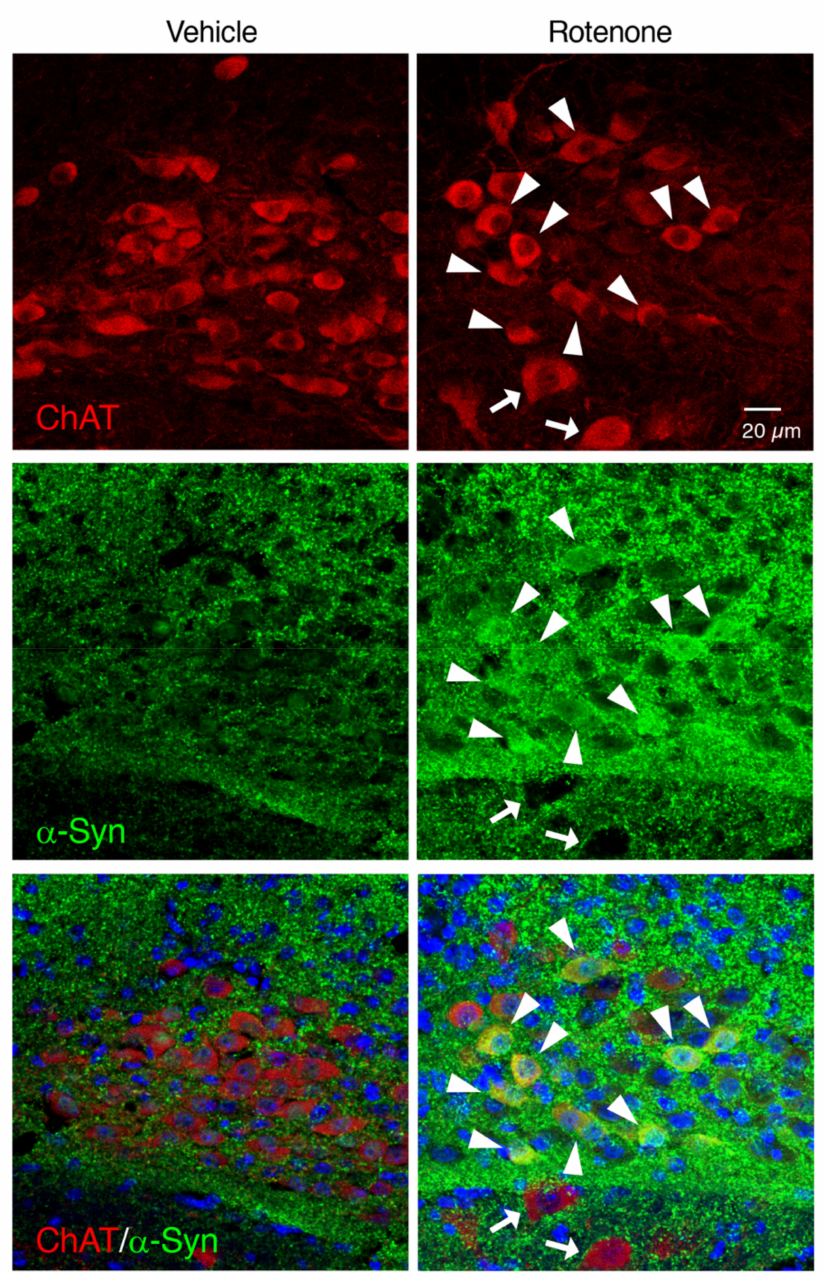
Figure7. Chronicexposuretolow-doserotenoneinduced α -Synaccumulationinthecholinergicneurons intheDMVofmice. RepresentativephotomicrographsofChATand α -Syndoubleimmunostaining. Red: ChAT-positive neurons. Green: α -Syn. Blue: nuclear staining with Hoechst 33342. Solid arrowheads: increased α -Syn signals in neuronal soma in the DMV. Arrows: α -Syn-negative neurons in the hypoglossal nucleus. Scale bar = 20 µ